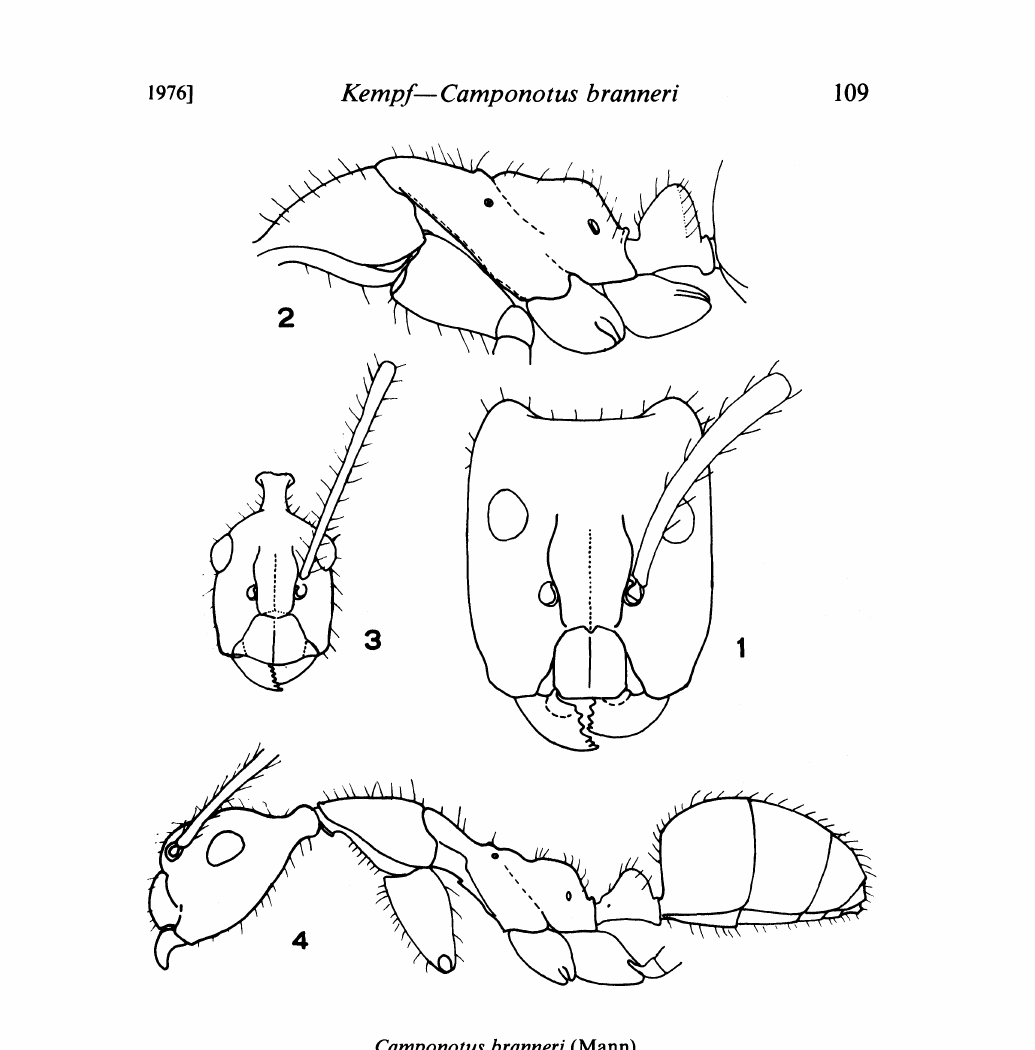
Fig. 1. Soldier, head in full-face view. Fig. 2. Soldier, thorax and petiole in side-view. Fig. 3. Worker, head in full-face view. Fig. 4. Worker in